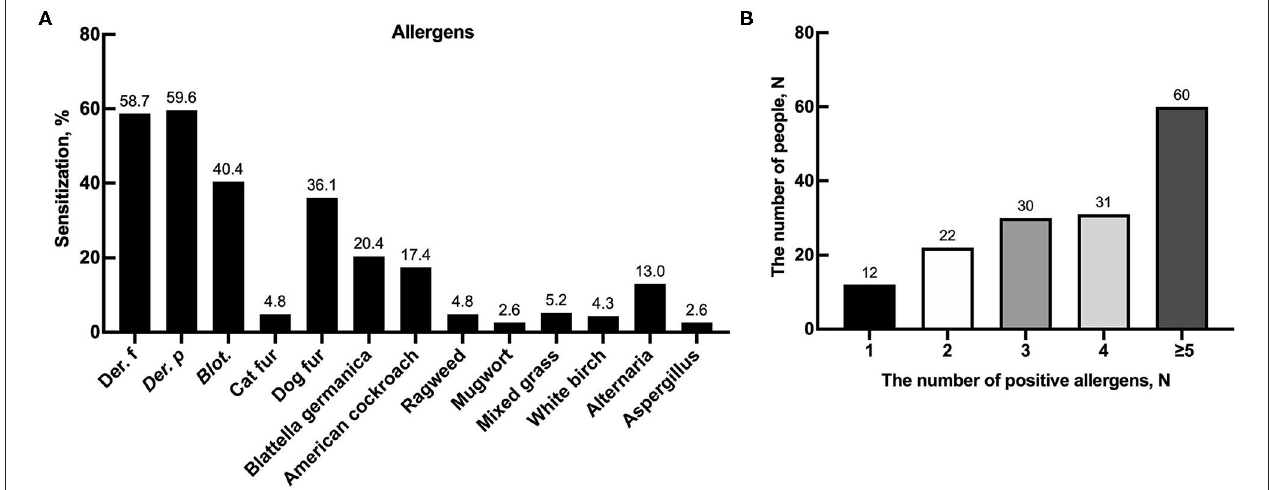
FIGURE 1 | Allergic sensitizations in patients. (A) Sensitization to 13 aeroallergens based on SPTs in children with AR and/or asthma. (B) The number of people in different number of positive allergens in all person.